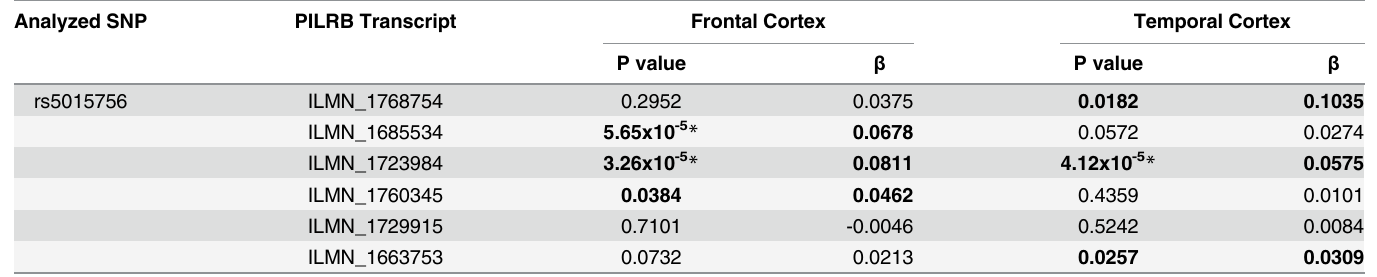
Table 4. SNPs in LD with rs1476679 produce eQTL with PILRB in control brains (GSE15745). Analyzed SNP